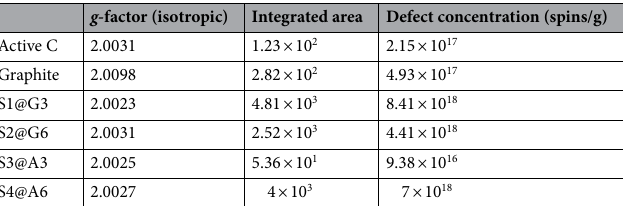
Table 2. g -factors, integrated area of EPR signal, and the accurate defect concentration of carbon-based starting materials and B 4 C samples synthesized via various